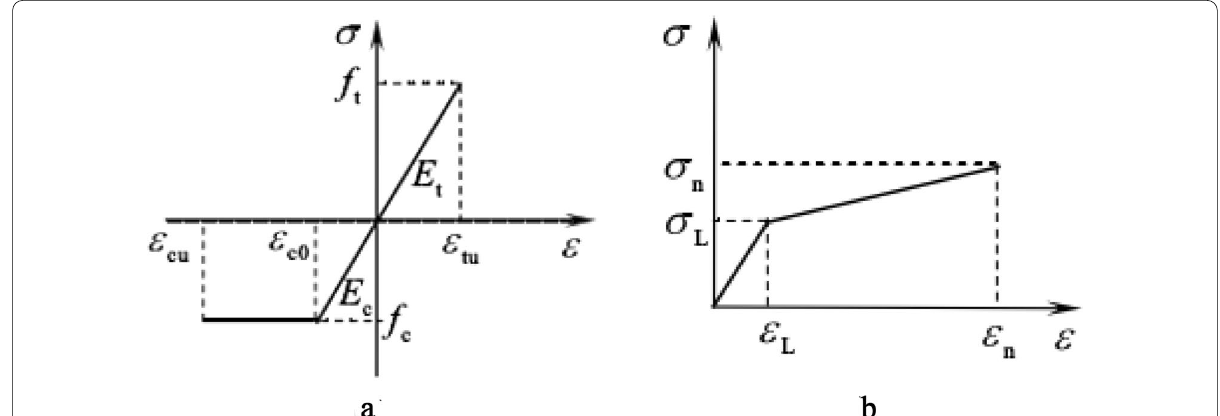
Fig. 16 Stress–strain relation of timber: a parallel to grain; b compression in the radial